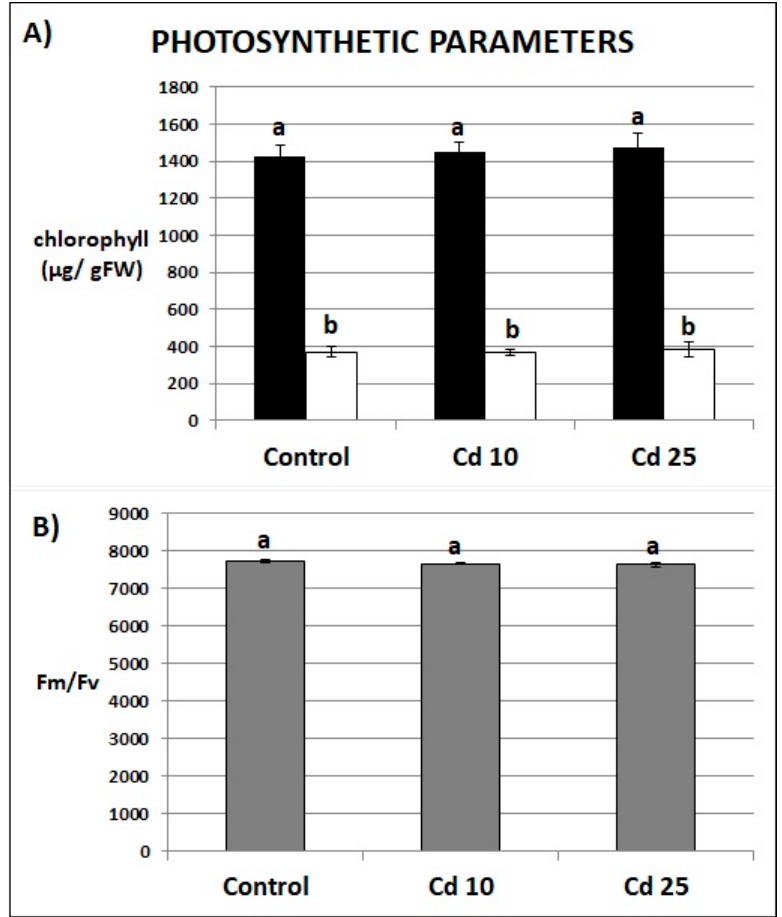
Figure 5. Content of chlorophyll a (black bars) and chlorophyll b (white bars) ( A ) and Fv/Fm ratio ( B ) of plants after 7 days of recovery periods. Results are the means of three independent experiments ± SE . Results showing no statistically significant differences by p = 0.05 are marked with the same letter.